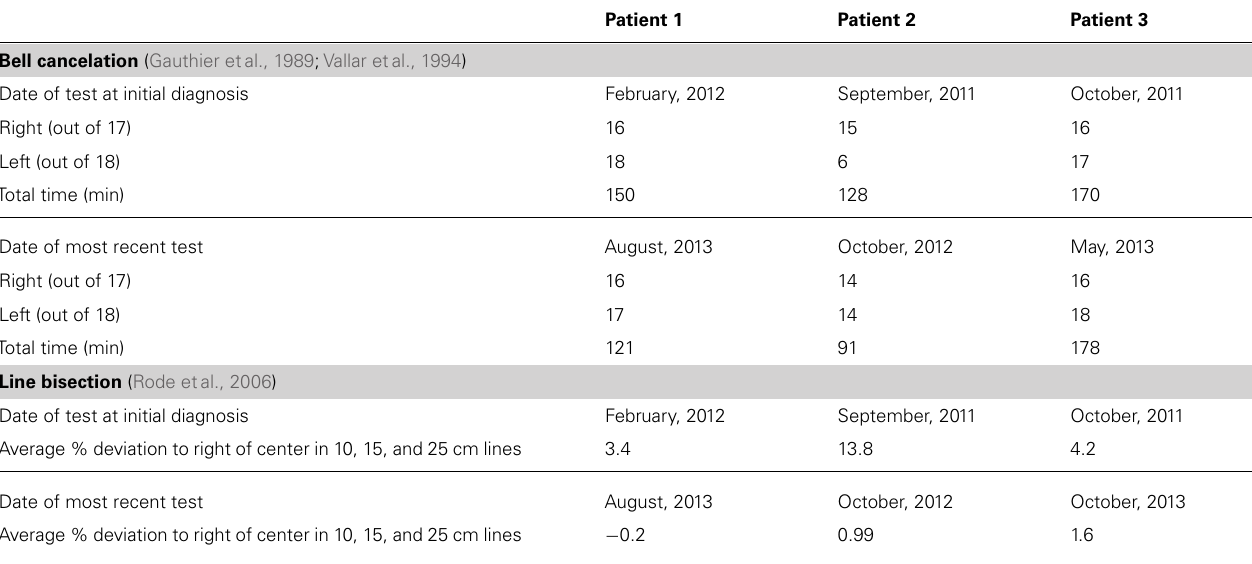
Table 1 | Patients’ performance on the bell cancelation (e.g., Gauthier etal., 1989;Vallar etal., 1994) and line bisection tasks (e.g., Rode etal., 2006) after the date of their initial diagnosis at CeRiN, as well as their most recent scores on each